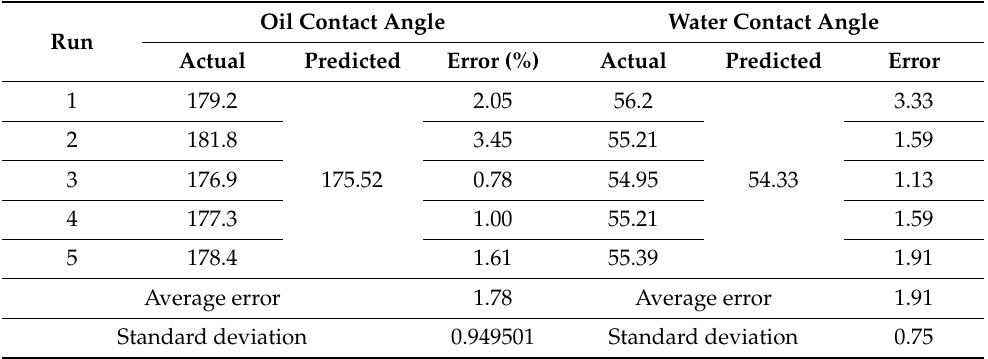
Table 7. Confirmatory Test for Optimum Responses of OCA and